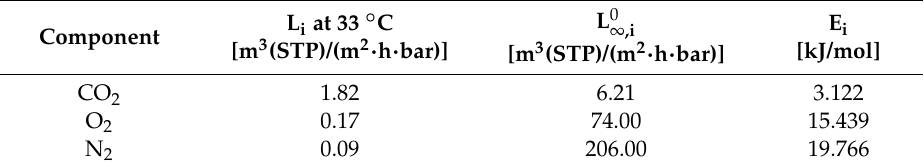
Figure 10. Arrhenius plot of the temperature depending single gas permeances of CO 2 , N 2 and O 2 of SILM M1c15 (average pressure ~250 mbar). Table 3. Arrhenius model parameters of CO 2 , O 2 and N 2 (temperature range of 21–67 ◦